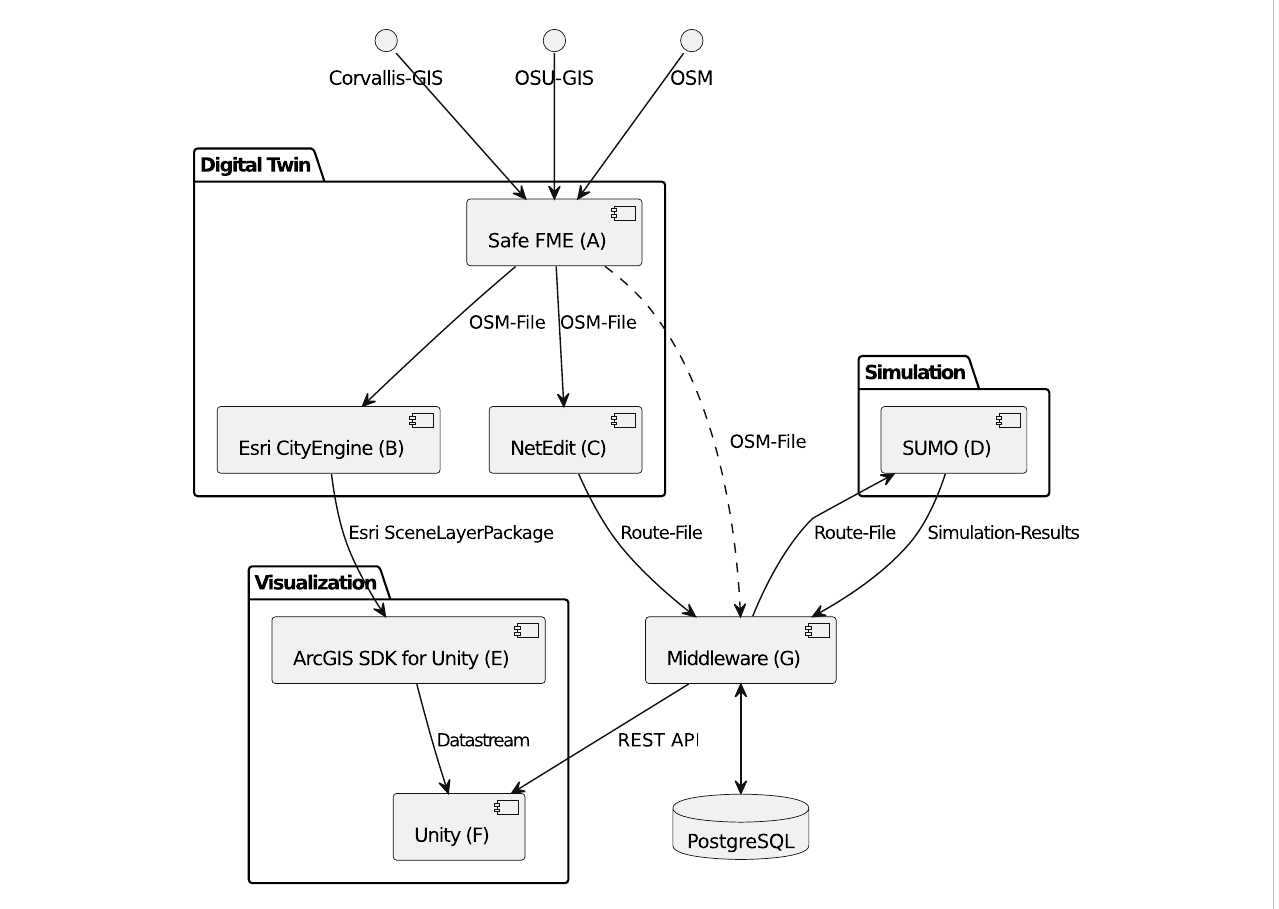
FIGURE 1 Overview of the various software components used for establishing the Digital Twin and the simulation. The fi gure shows the interaction between the components.